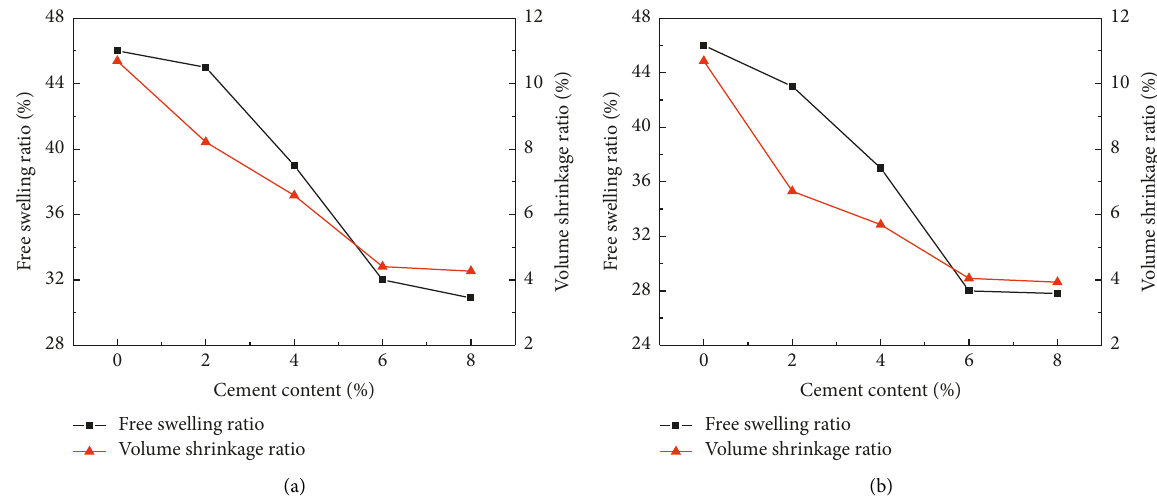
Figure 5: Swelling-shrinkage behaviors of cement-stabilized soil under different curing periods. (a) 7 days. (b) 28 days.